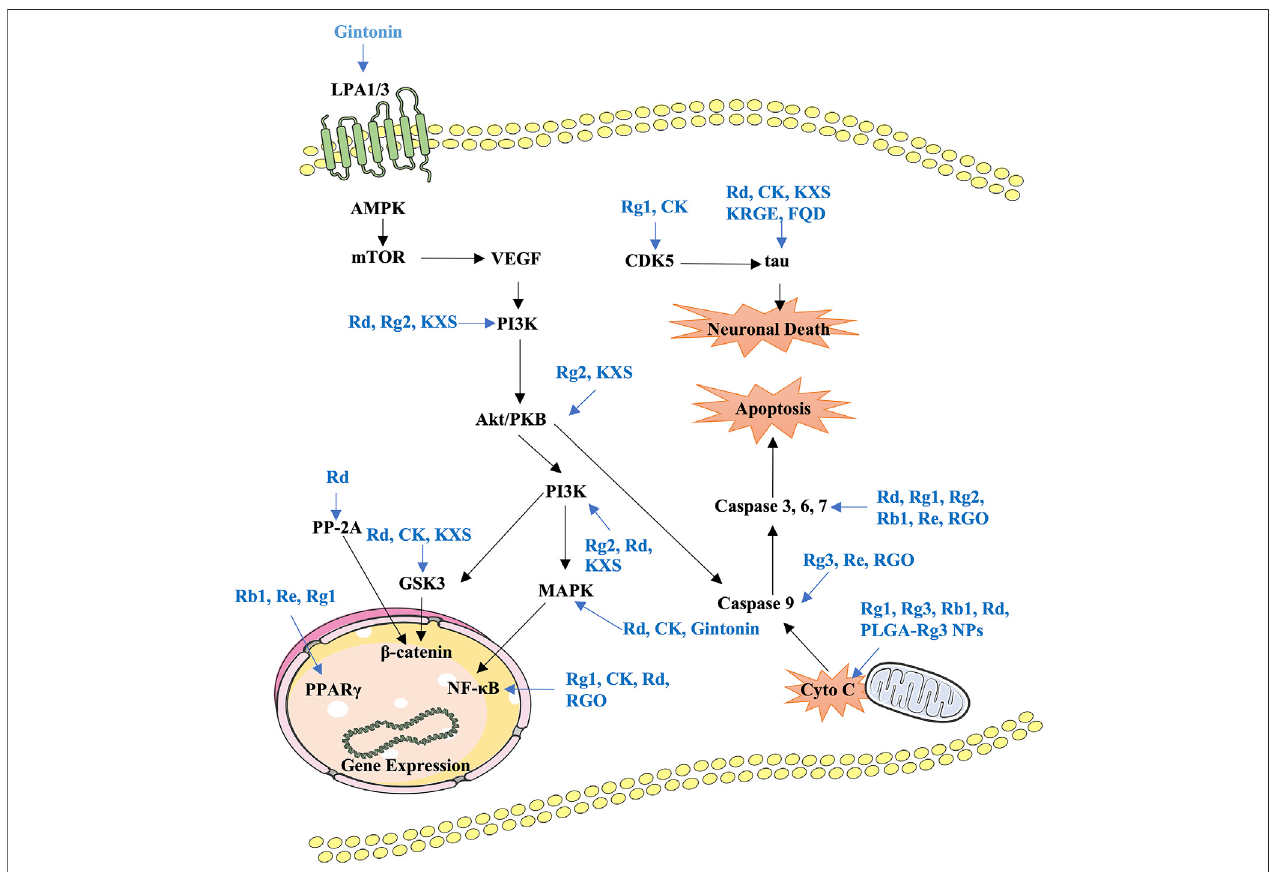
FIGURE 2 | Summary of the functional effects of ginseng on AD via multiple links across regulatory mechanisms and multitarget effects. LPA, lysophosphatidic acid; KXS, Kaixin-San; PP-2A, protein phosphatase 2A; RGO, red Ginseng oil; Cyto C, cytochrome C.